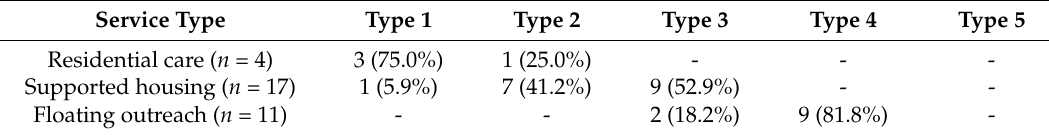
Table 8. Service manager STAX-SA classifications according to supported accommodation